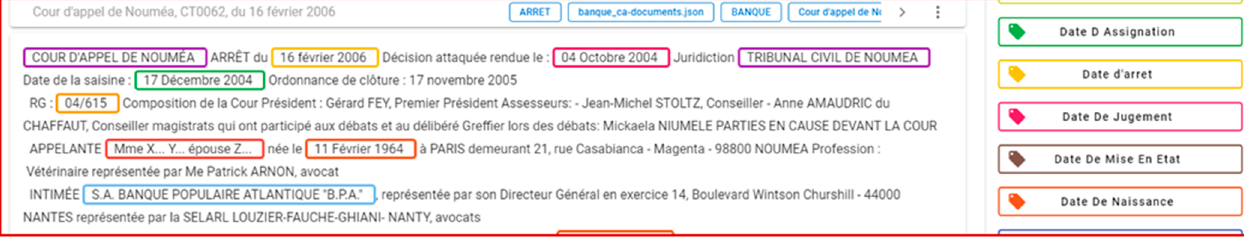
Figure 1. Example of annotations in a court case.